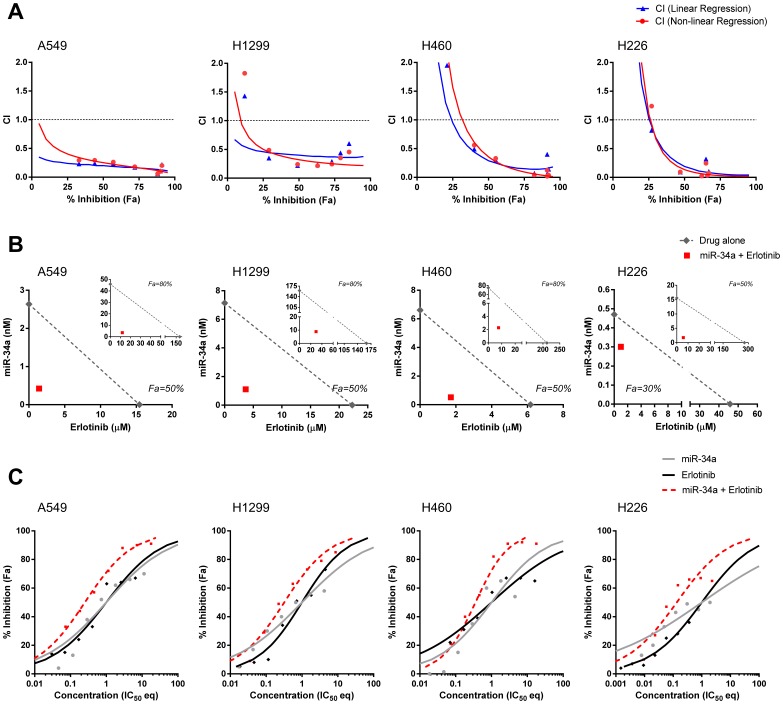
Synergistic effects between miR-34a and erlotinib in NSCLC cells.(A) Combination index (CI) analysis. CI values were generated by linear regression (red) and non-linear regression methods (blue). Trendlines indicate CI values at any given effect (Fa, fraction affected, % inhibition), and symbols represent CI values derived from actual data points. CI = 1, additivity; CI>1, antagonism; CI<1, synergy. (B) Isobologram analysis. The diagonal, dotted line indicates additivity, and the red symbol shows dose requirements to achieve 50% and 80% (A549, H1299, H460) or 30% and 50% (H226) cancer cell inhibition, respectively. Data points below the line of additivity indicate synergy, data points above denote antagonism. (C) Curve shift analysis. Data derived from non-linear regression trendlines were normalized to IC50 values of the single agents (IC50 eq) and plotted in the same graph. Left and right shifts of the dose-response curves of the combination (red dotted line) relative to the dose-response curves of the single agents (grey, black) indicate synergy or antagonism, respectively. Actual experimental data points are shown (symbols).